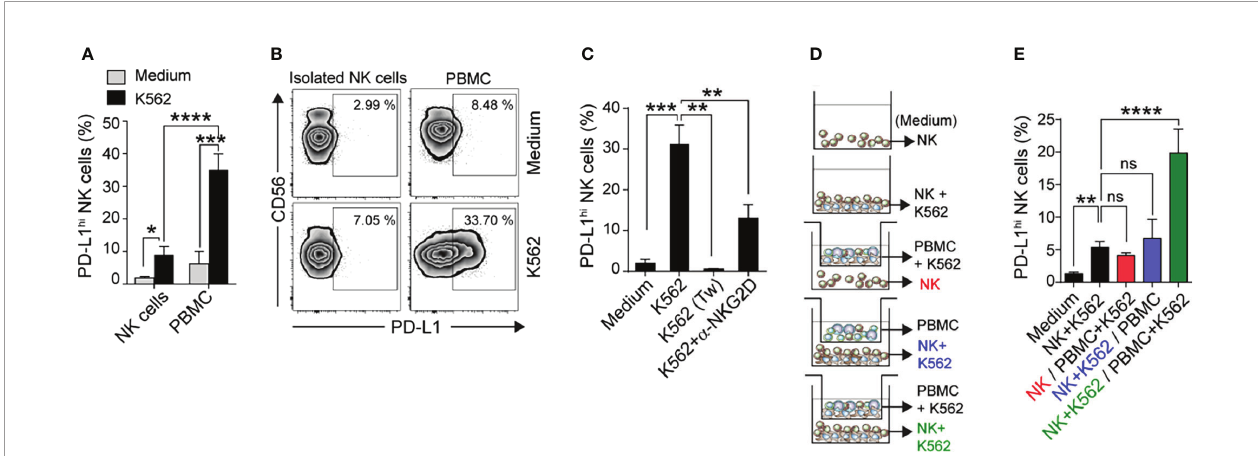
FIGURE 3 | Emergence of PD-L1 hi NK cells requires contact with tumor cells and PBMC-derived soluble factors. (A) Frequency of PD-L1 hi NK cells after culture of isolated NK cells or PBMC in the absence (Medium) or in the presence of K562 cells for 48 h, assessed by fl ow cytometry (n=7-11). (B) Representative zebra plots. (C) Frequency of PD-L1 hi NK cells after culture of PBMC in the absence (Medium) or in the presence of K562 cells, in contact or separated by a Tw, or in the presence of anti-NKG2D blocking mAb for 48 h, assessed by fl ow cytometry (n=4). (D) Experimental design used to assess the requirements for the induction of PD-L1 hi NK cells. Isolated NK cells, PBMC and K562 cells were cultured separated by Tw as indicated in the fi gure. (E) Frequency of PD-L1 hi NK cells after culture of isolated NK cells in the absence (Medium) or in the presence of K562 cells or PBMC together or separated by Tw, assessed by fl ow cytometry (n=3). Data represent mean ± SEM. Two-way ANOVA with Sidak´s multiple comparison (A) and one-way ANOVA with Dunnett´s (C) and Tukey´s (E) posthoc. ns, non- signi fi cant; * p <0.05, ** p <0.01, *** p <0.001, **** p